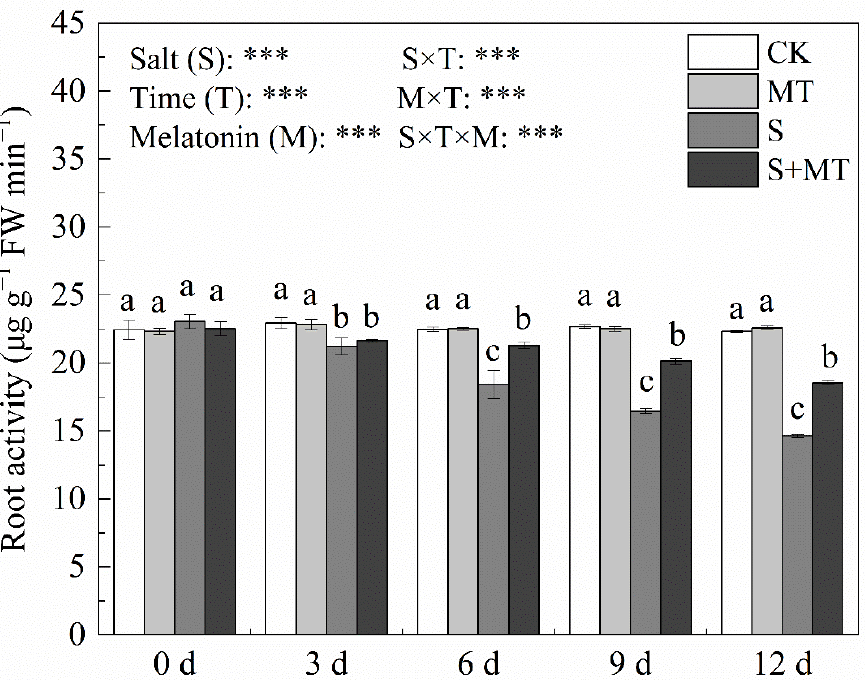
Figure 4. Effect of exogenous application of melatonin on the root vigor of C. leucochlora seedlings under salt stress. The error bars represent the standard deviation. Significance levels are presented for each main effect or interaction. ns: not significant; *** p < 0.001.